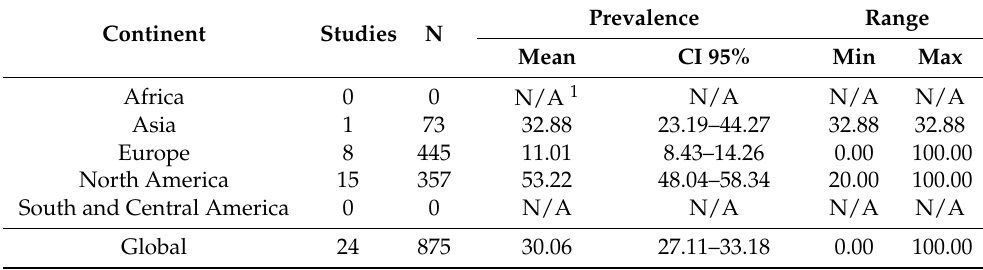
Table A7. Flock SLRV prevalence in each continent from 1991 to 2000.